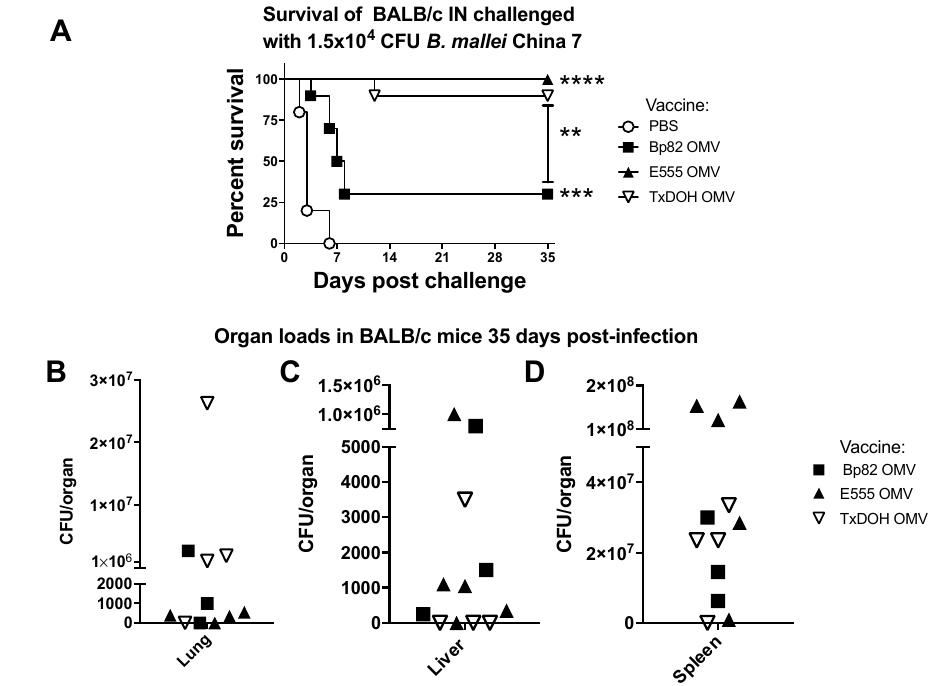
Figure 6. OMV vaccination protects BALB/c mice from acute lethal glanders following intranasal inoculation. ( A ) Survival to 35 days of 4–6 weeks old BALB/c mice intranasally challenged with 1.5 × 10 4 CFU B. mallei China 7 after prime-boost-boost vaccination with the Bp82-, E555-, TxDOH-derived OMV (each group n = 10) or PBS (n = 5). Statistically significant increases in survival compared to PBS or each other as indicated were determined by the Log-rank (Mantel-Cox) test where ** p ≤ 0.01, *** p ≤ 0.001, **** p ≤ 0.0001. Bacterial loads in the lungs ( B ), livers ( C ), and spleens ( D ) of 35-day survivors. In panels ( B – D ) each symbol equals one mouse.